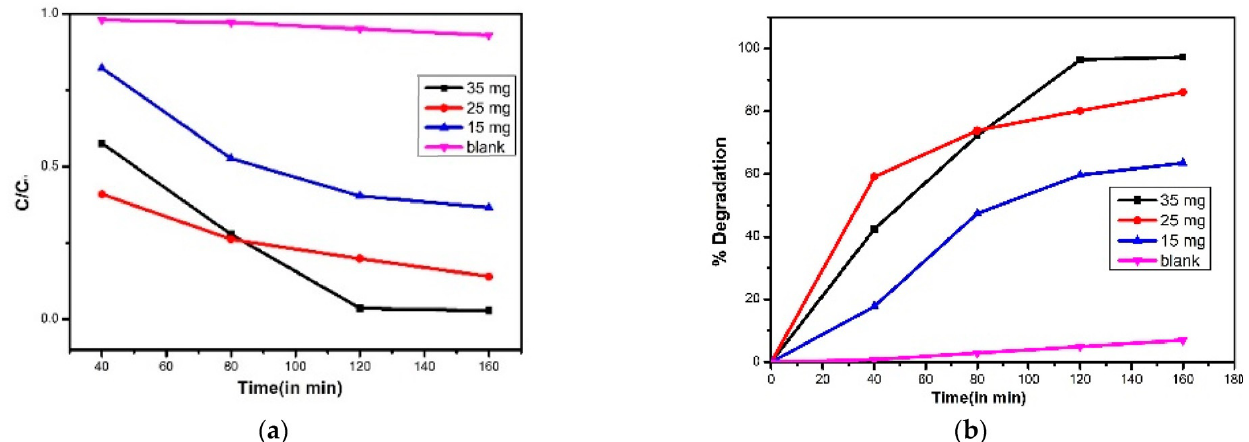
Figure 7. ( a ) Degradation profile for 10 ppm caffeine using 15 mg, 35 mg, and 25 mg catalyst. ( b ) Degra- dation efficiency of 15 mg, 25 mg, and 35 mg of catalyst for degrading 10 ppm caffeine solution.